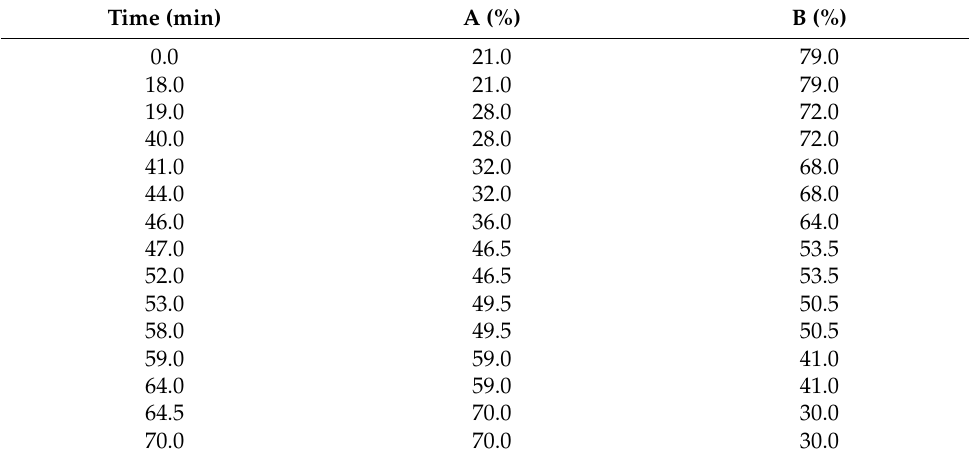
Table 1. The gradient elution procedure of the